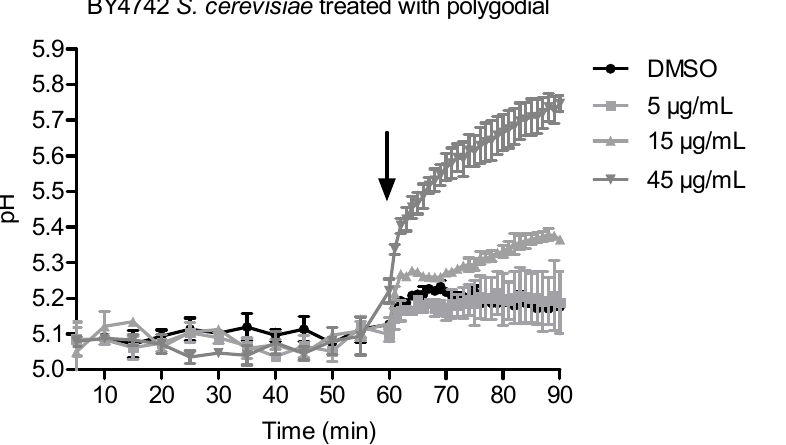
Figure 3. Vacuolar pH measurements in S. cerevisiae WT in the presence of the vehicle (DMSO) or 5, 15, and 45 µ g/mL polygodial, mean with standard error of the mean (SEM), n = 2. Baseline measurements were first taken for 1 h in the presence of calibration buffers, then polygodial and DMSO were added in their respective wells, and the plate was further measured for 30 min. The arrow indicates addition of polygodial shortly after 60 min.